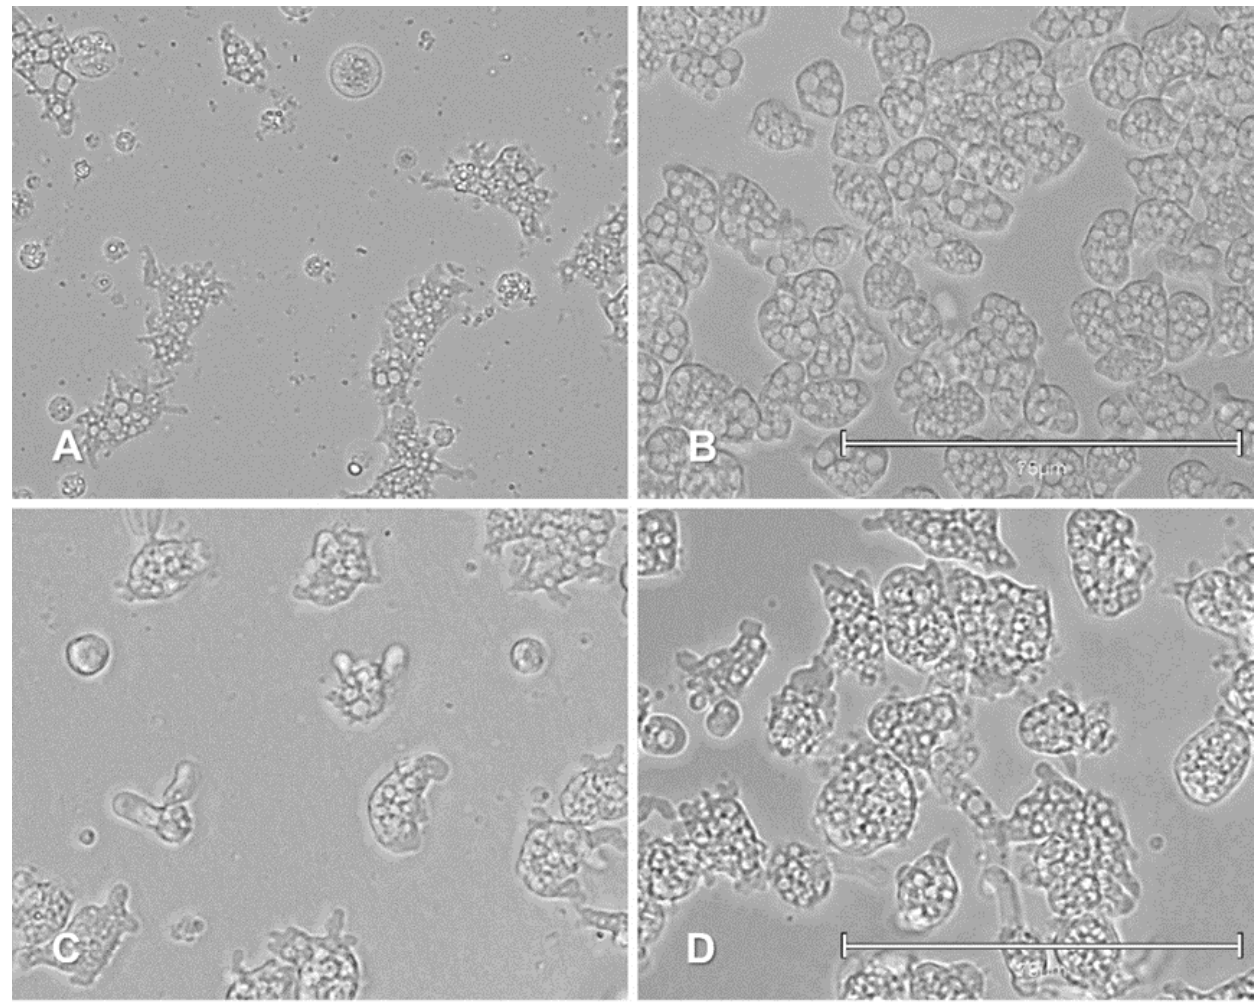
Figure 3. Growth inhibition of Naegleria fowleri (ATCC ® 30808™) trophozoites at 48 h at IC 50 concentration. Compound 3 ( A ) and negative control ( B ) with Naegleria fowleri (ATCC ® 30215™) trophozoites at 48 h at IC 50 concentration. Compound 3 ( C ) and negative control ( D ). All images (40 × ) are representative of the cell population of treated amoeba and are based on the EVOS™ M5000 Imaging System, Invitrogen by Thermo Fisher Scientific, Madrid, Spain. Scale bars represent 75 µm. Table 1. Inhibitory concentrations (IC 50 /IC 90 ) of the evaluated compounds against the trophozoite stage of Naegleria fowleri type strains ATCC ® 30808™ and ATCC ® 30215™, and cytoto xicity values (CC 50 ) against murine macrophages J774A.1 strain ATCC ® TIB- 67™. N/D indicates that values were not determinate. The selectivity index (SI) of the active compounds was also calculated.